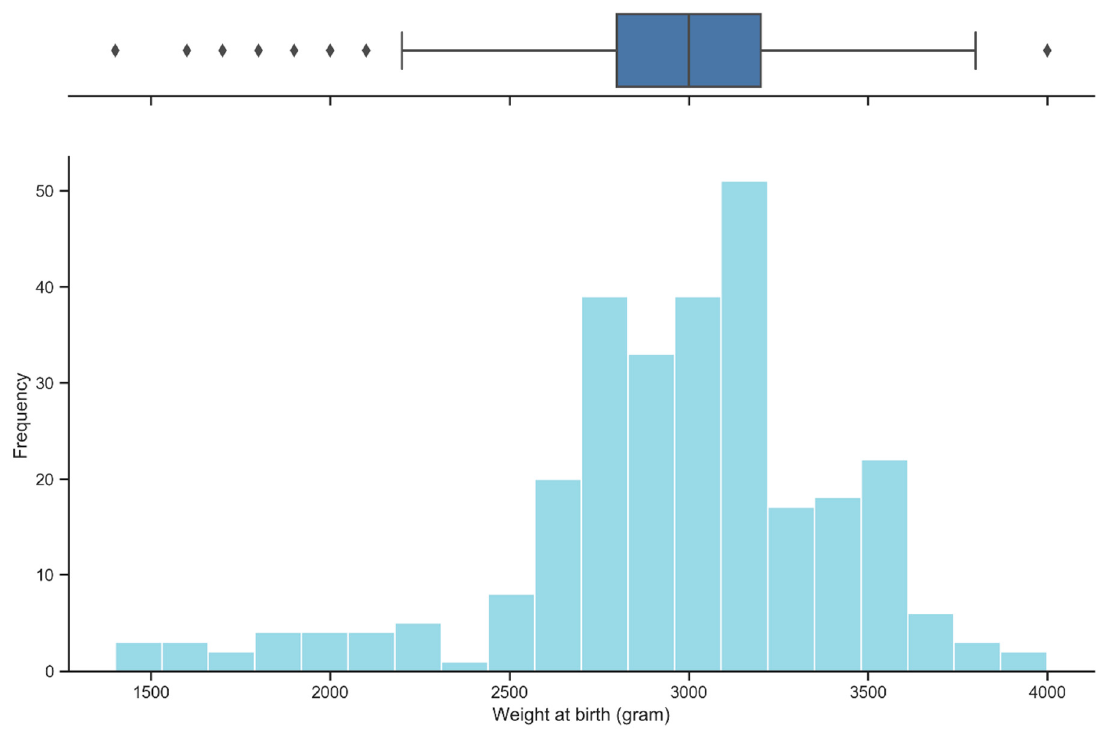
Figure 2. Babies’ weights at birth ( n = 284).